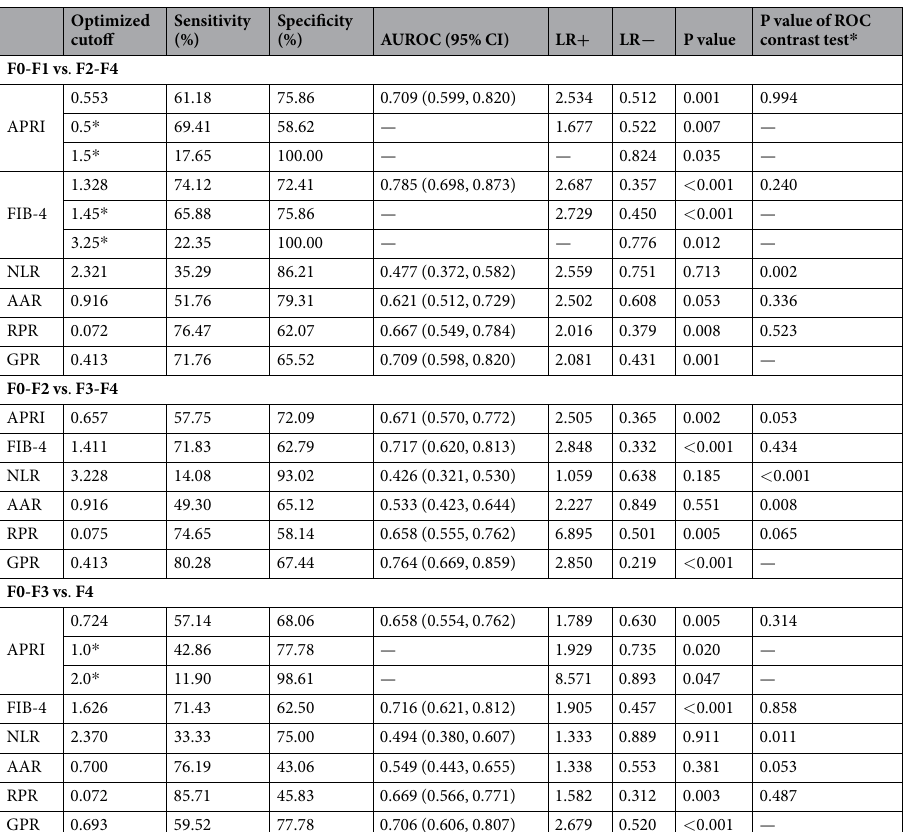
— Table 4. Diagnostic accuracy of different indexes for the prediction of liver fibrosis in HBeAg negative CHB. * Compared with GPR. AUROC, area under the receiver operating characteristic curve; CI, confidence interval; LR − , negative likelihood ratio; LR + , positive likelihood ratio; AAR, aspartate aminotransferase/alanine aminotransferase ratio; APRI, aspartate aminotransferase-to-platelet ratio index; FIB-4, fibrosis index based on the four factors; GPR, gamma-glutamyl transpeptidase to platelet ratio; NLR, neutrophil-to-lymphocyte ratio; RPR, red cell distribution width-to-platelet ratio. * Threshold recommended by the WHO 12